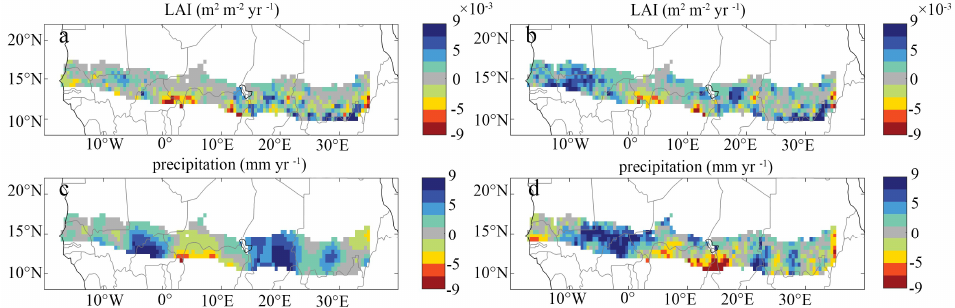
Figure 7. Grid trends (per year) of LAI (m 2 m − 2 yr − 1 × 10 − 3 ) from 2001 to 2016 and precipitation (mm yr − 1 ) from 1999 to 2016. ( a ) The GIMMS LAI3g. ( b ) The MODIS LAI. ( c ) The CRU precipitation. ( d ) The TRMM 3B43 precipitation.